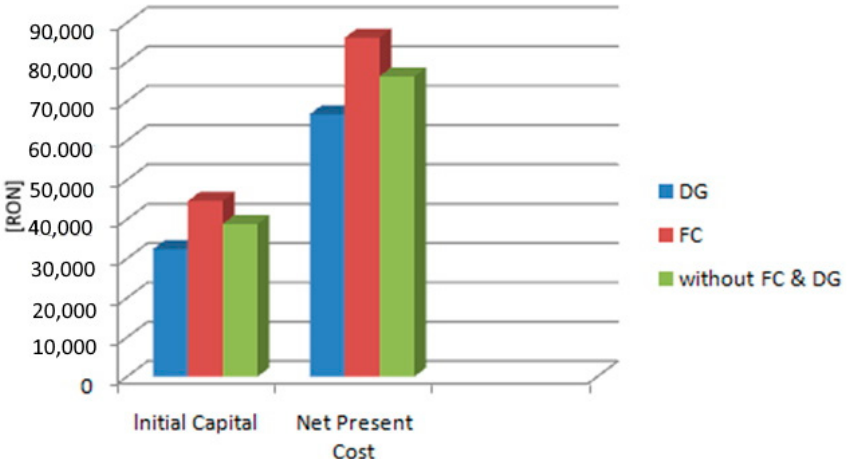
Figure 22. Economical comparison of the three cases using iHOGA.